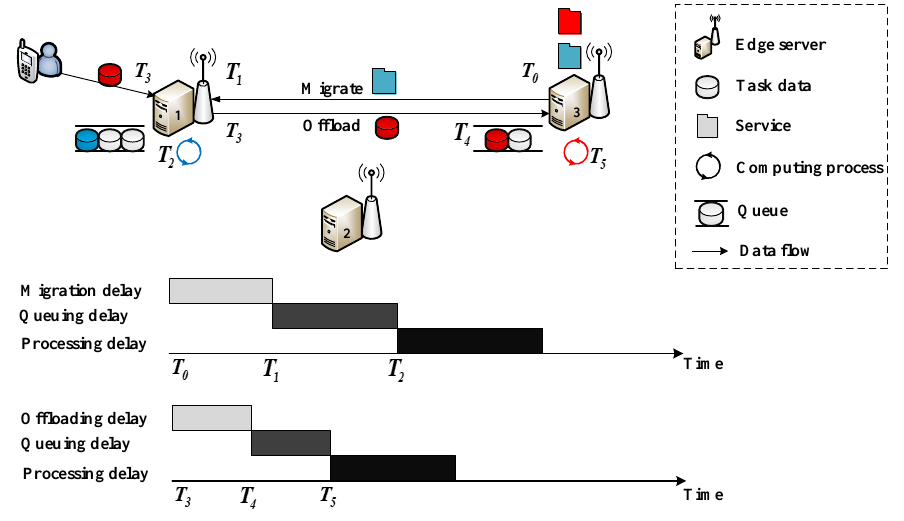
Figure 2. Task processing for migration and offloading strategies.